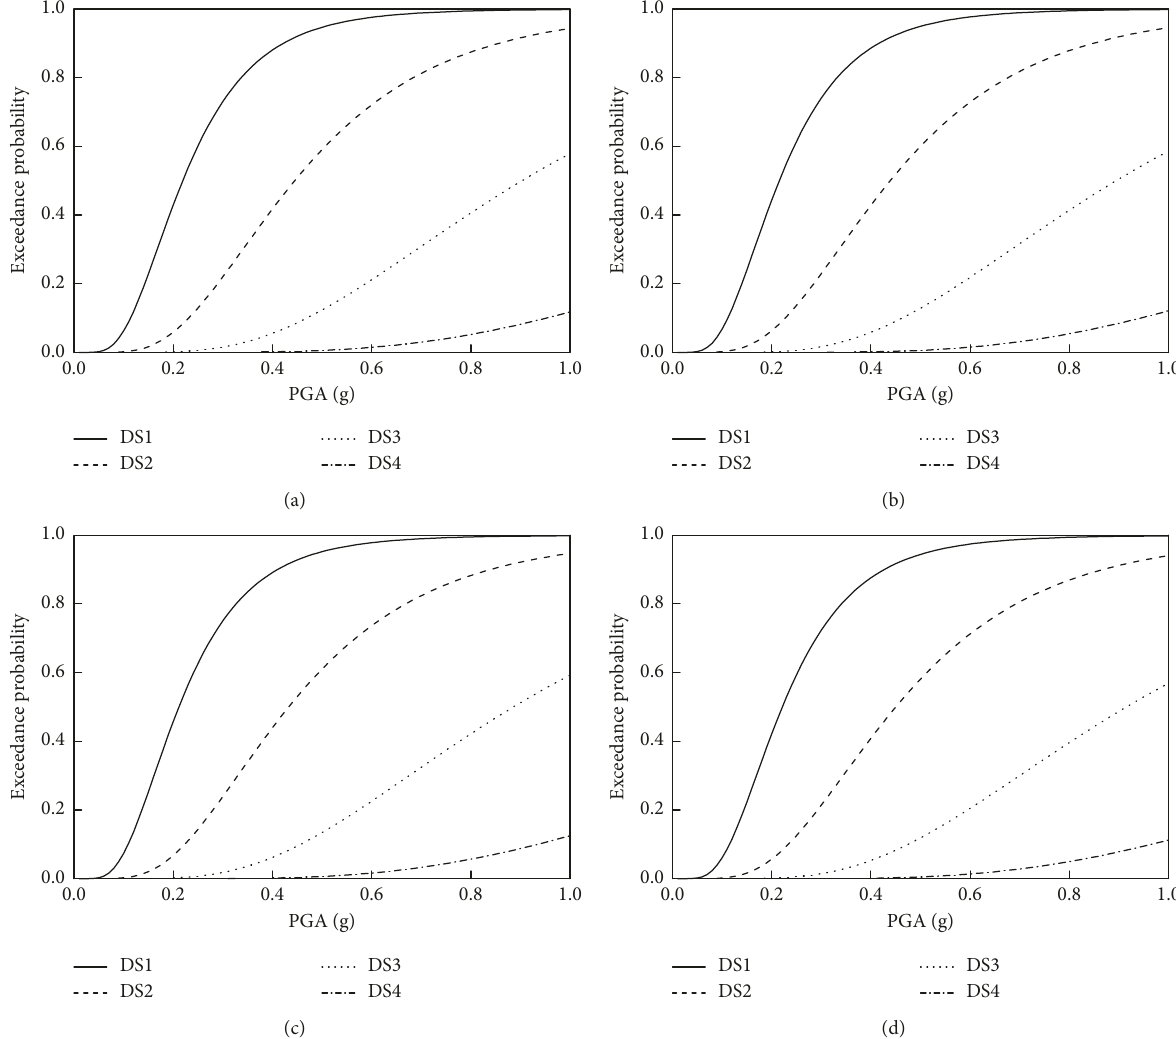
Figure 15: Structural peak relative displacement when μ defined by the structural peak relative displacement in Table 2). (a) V d 1 and C 0.003m 0kN s/m. (d) V d (c) V d (cid:31) (cid:31) · −